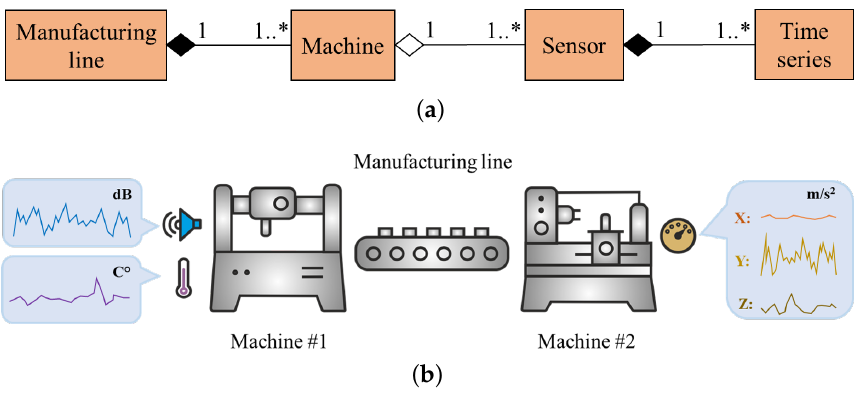
Figure 1. Model subject domain. ( a ) Class diagram, ( b ) Illustrative